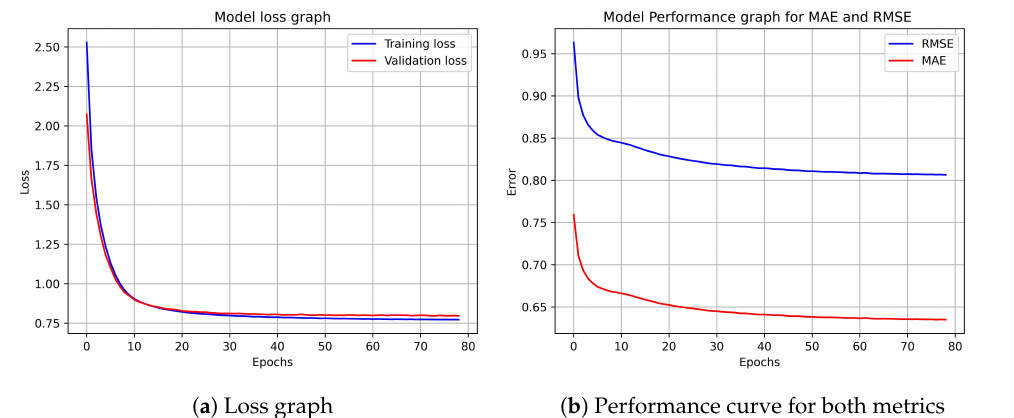
Figure 3. A model with 2 hidden-layer for the ML-1M dataset. In Part ( a ), we have the training and validation loss curve versus the number of training epochs, and in Part ( b ), we have the performance results. As observed, the method